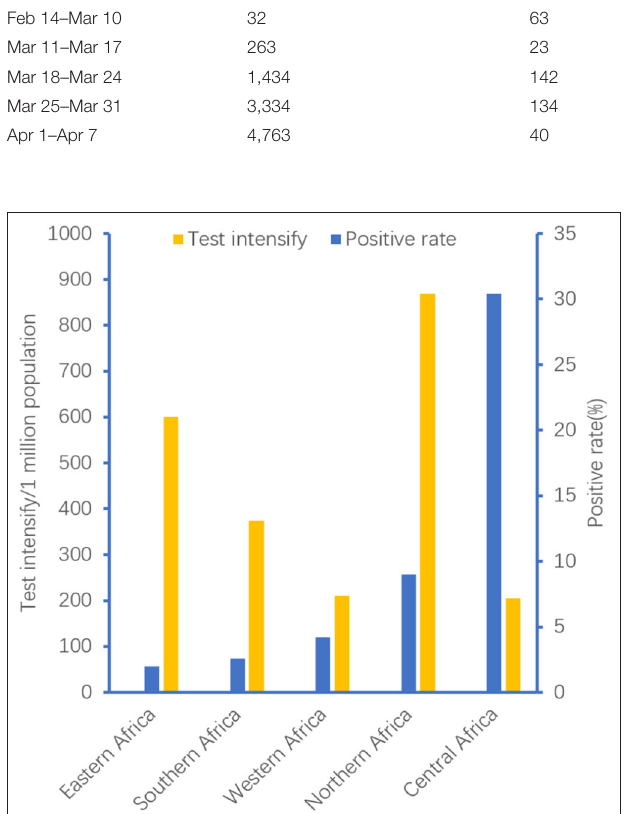
FIGURE 5 | Predictive curve of transmission dynamics of COVID-19 in Africa